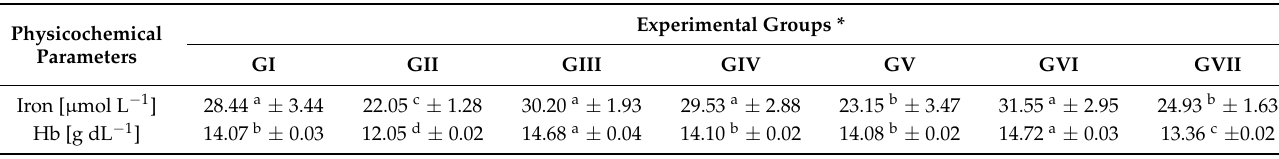
Table 4. Effect of SP, KF, KP, and SFP extracts on blood iron and Hb concentrations of indomethacin-induced gastric ulcer in rats (mean ± SE), n = 6.